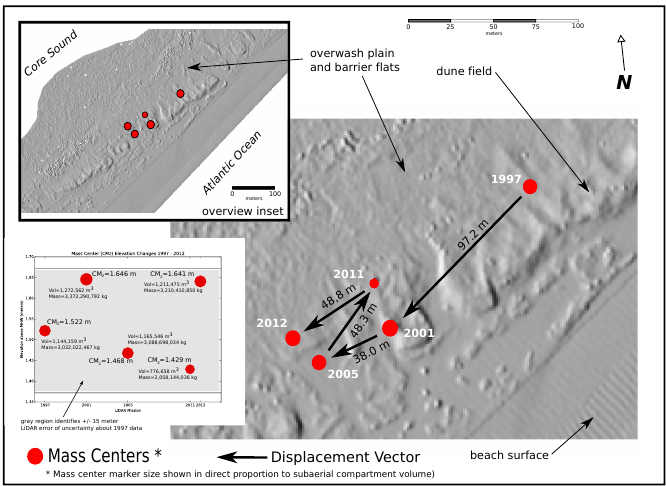
Figure 4. Mass center (CM) displacement, both in the horizontal and vertical directions. The overview insert in the upper left juxtaposes the five CMs over the Core Banks site in the context of their dune field positions relative to the Core Sound and Atlantic Ocean shorelines. The CM inset plots the changing shift in position for the vertical component ( CM z the CM. Also shown are total subaerial sediment (sand) volumes and masses. The main plot shows the CMs horizontal components and their displacement through time across the island. The CM symbol diameter is proportional to the subaerial volume.